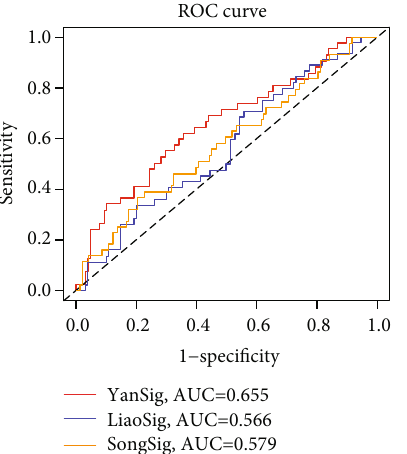
Figure 10: Comparison of models. The model in this article is compared with the model proposed by Liao et al. and the model proposed by Song et al. The model proposed in this paper has the highest AUC value and the best predictive